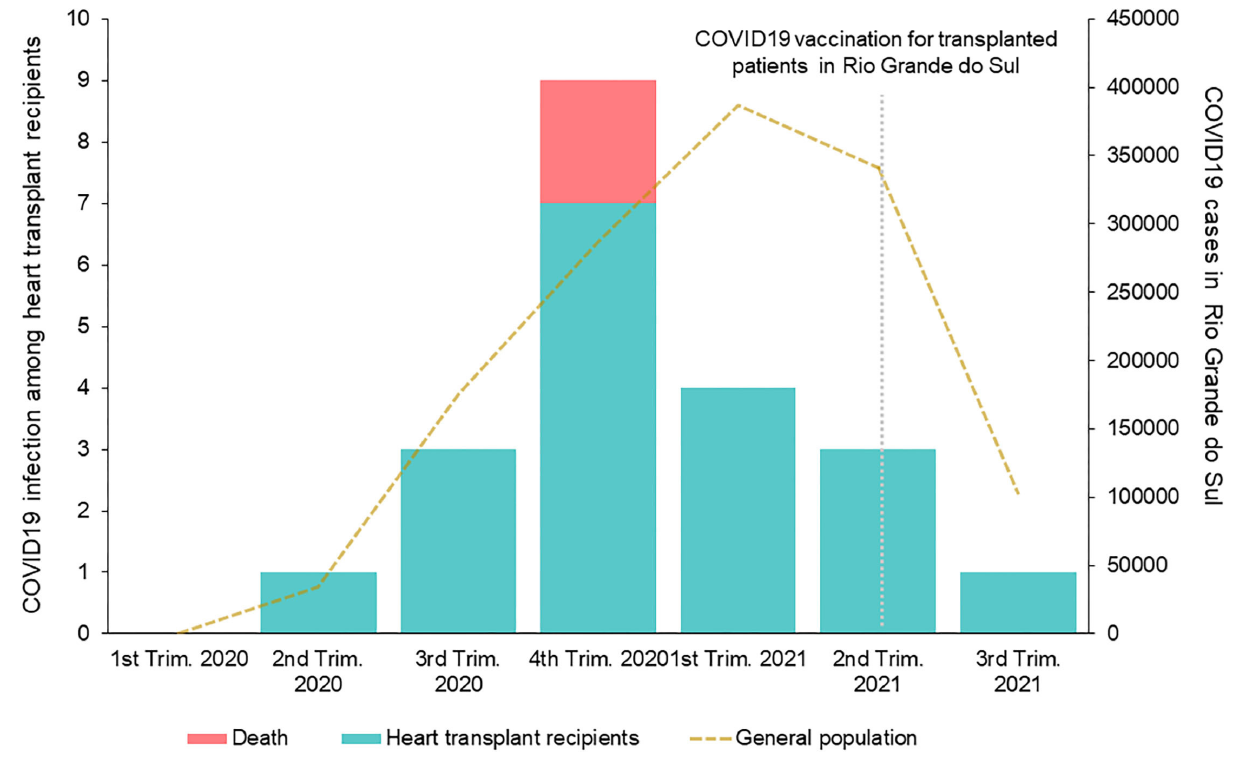
FIGURE 1 | Temporal incidence of COVID-19 infection in the general population and the heart transplant recipient cohort in the State of Rio Grande do